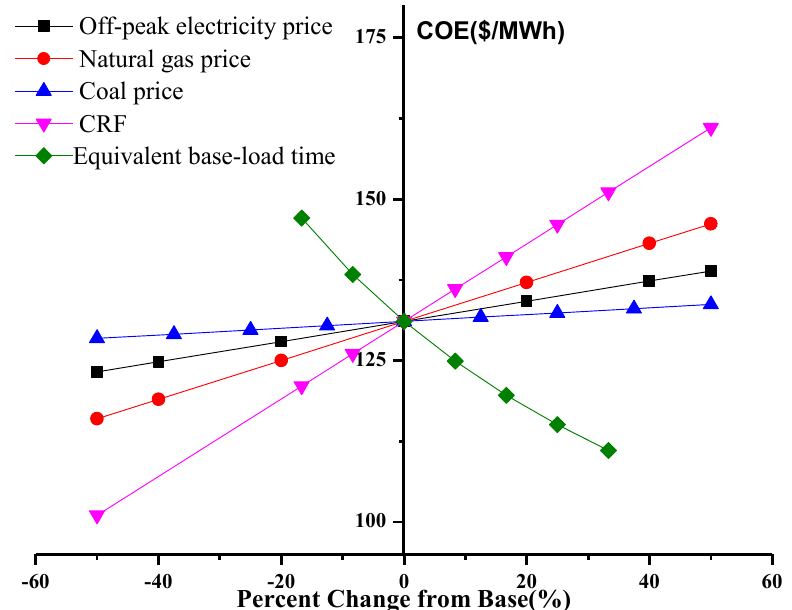
Figure 5. Sensitivity analysis of the COE of the hybrid-fuel CAES